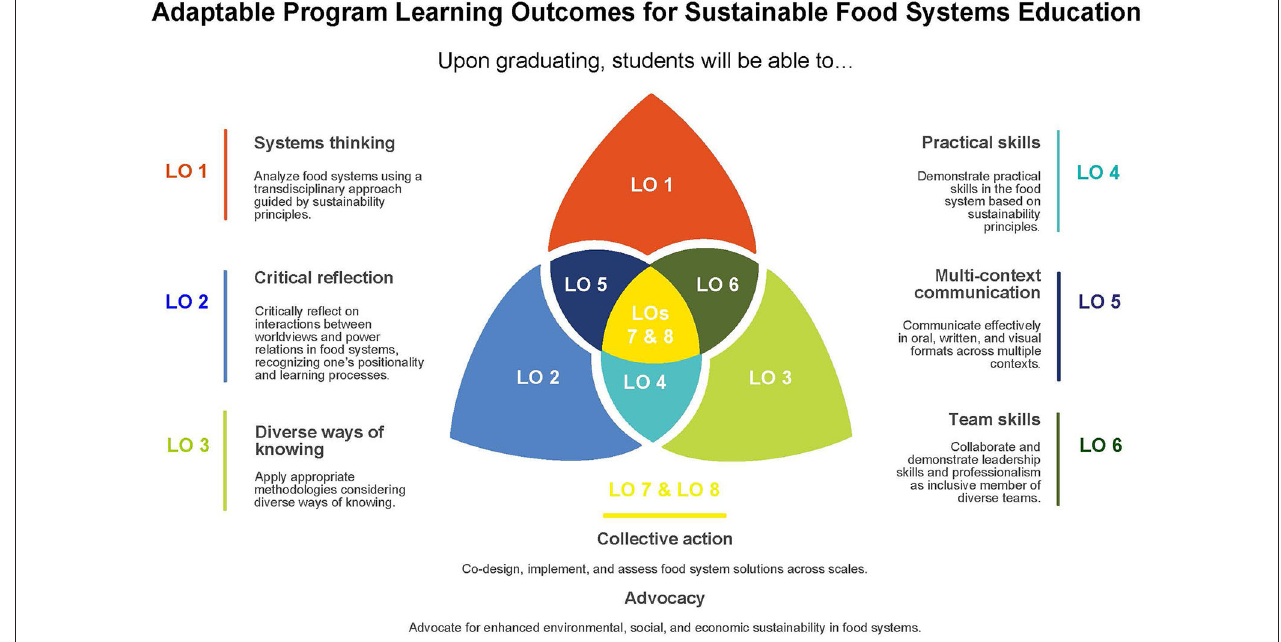
FIGURE 1 | The Eight adaptable Program Learning Outcomes for Sustainable Food Systems Education and their